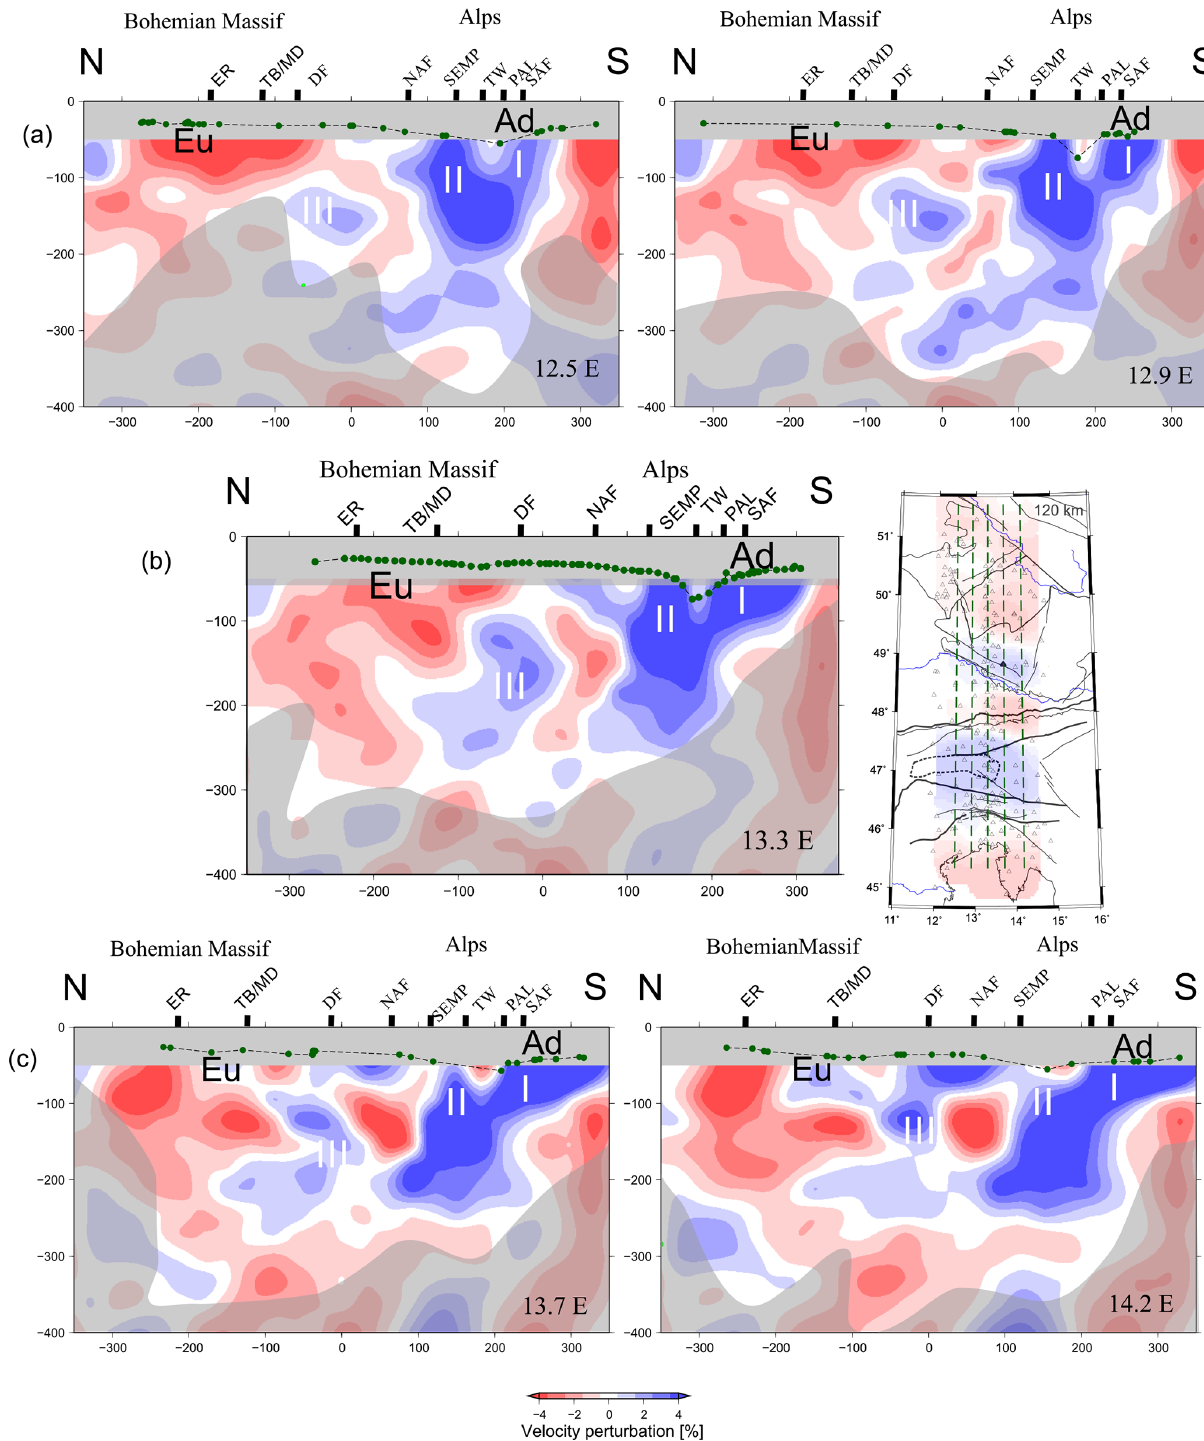
Figure 3. Five north–south-oriented vertical cross sections through the EASI + AA velocity perturbation model: (a) east of the EASI, (b) along the EASI profile, and (c) west of the EASI. The location of the cross sections is marked in the map in the central part of the figure. The along-longitude cross sections run from 51.65 to 45.35 ◦ N. Fault abbreviations are as earlier: Eu – Europe, Ad – Adria. Shading of the less well-resolved region was set according to the resolution matrix, ray coverage of grid cells, and derivative weighted sums. The contour follows a value of 0.15 of diagonal elements of the resolution matrix. Green dots mark Moho depths in the model used for calculation of crustal corrections (see also Fig. S3). Travel times are not inverted for velocity perturbations in the crust (nodes at 30km of